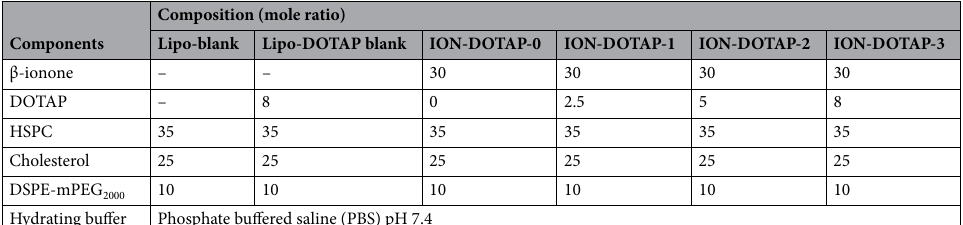
Table 2. Composition of β-ionone